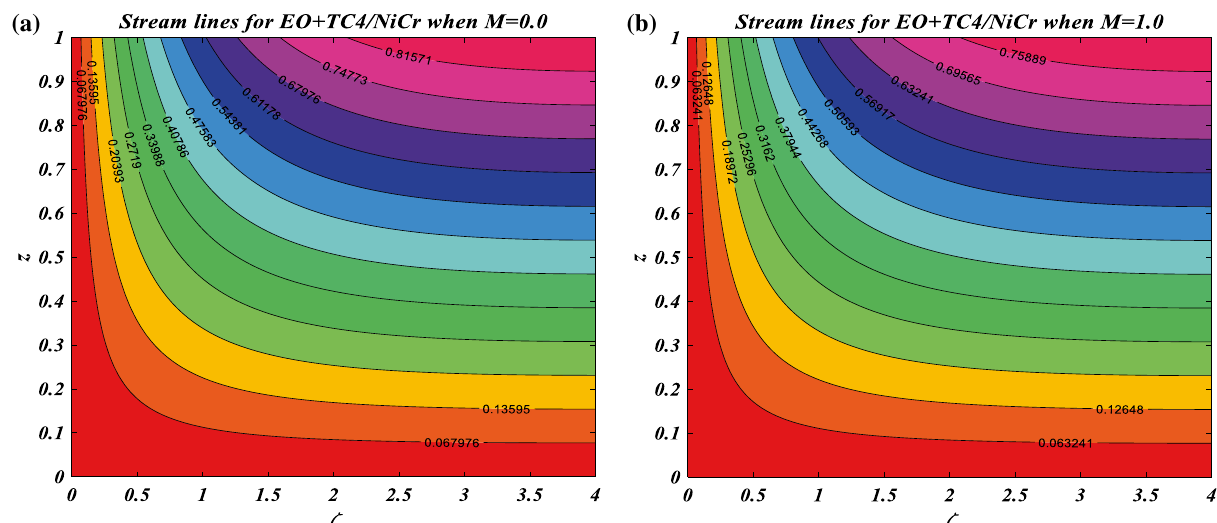
Figure 6. ( a ) Streamlines variation for EO + TC 4 / NiCr when M = 0.0 . ( b ) Streamlines variation for EO + TC 4 / NiCr when M = 1.0